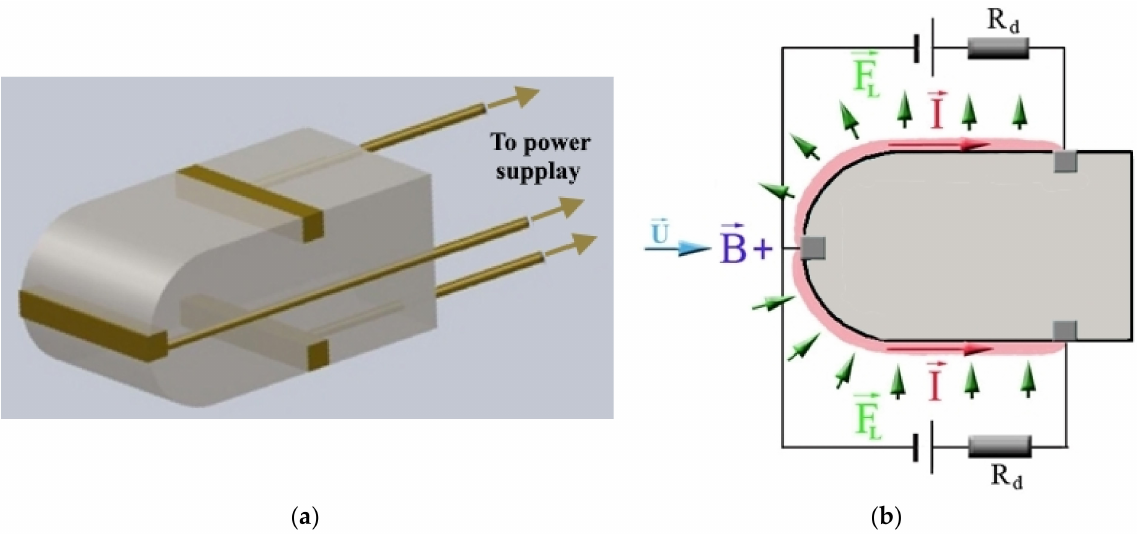
Figure 15. ( a ) Aerodynamic model with built-in electrodes; ( b ) Variant of closing the gas discharge current according to the tree-electrode circuit.